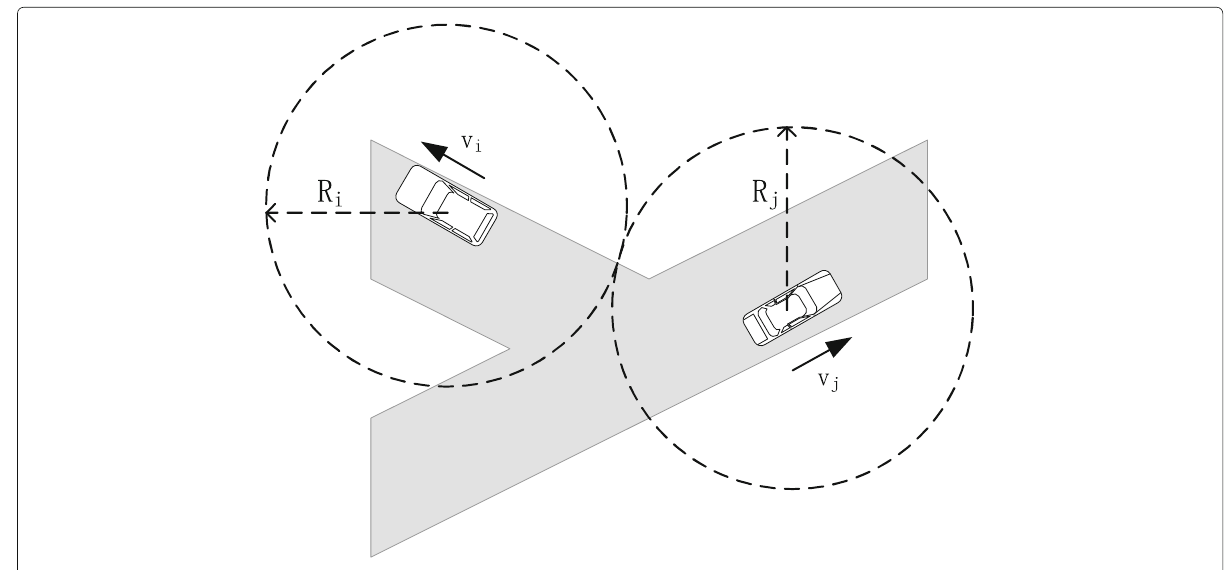
Fig. 4 Critical communication